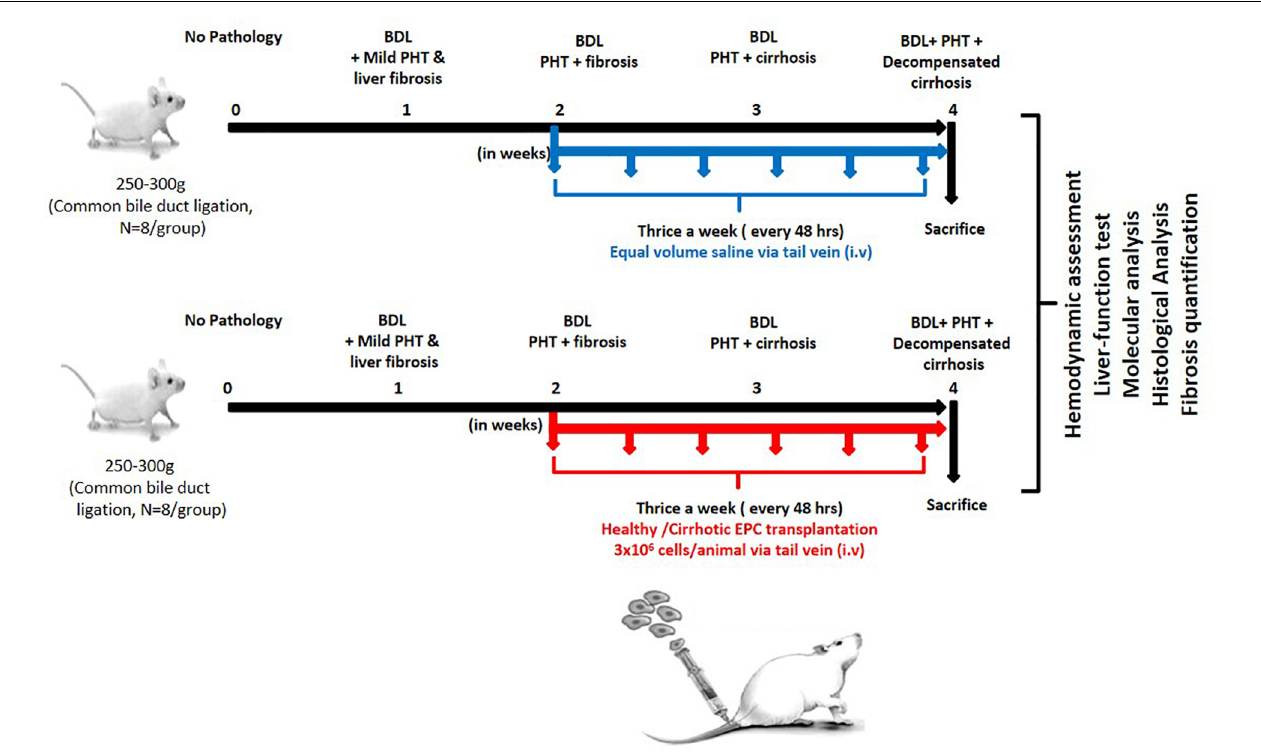
FIGURE 1 | Work plan for in vitro and in vivo studies. In the in vitro studies, human EPCs were isolated and cultured from healthy controls ( N = 10) and cirrhotic patients ( N = 10). In the in vivo studies, the cultured EPCs from healthy controls and patients were transplanted into bile duct-ligated rats ( N = 8 each) via the tail veil. Saline-treated rats served as the control group ( N = 8).